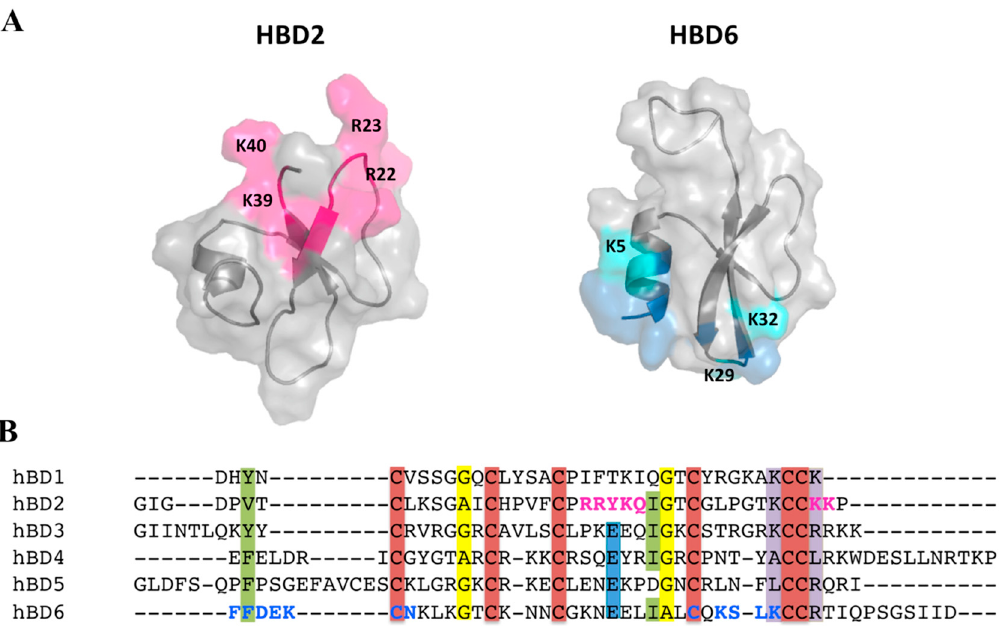
Figure 5. β -Defensin interaction with glycosaminoglycan (GAG), mapped using nuclear magnetic resonance (NMR) chemical shift perturbation (CSP). ( A ) Comparison of the heparin-binding motif mapped on the surfaces of human β -defensin (HBD)2 and HBD6. Residues exhibiting pronounced NMR CSP upon GAG binding are highlighted in magenta for HBD2 [53] and blue for HBD6 [41] on the surface and in the primary sequence. The CSPs for HBD2 were reproduced from [53]. ( B ) Sequence alignments for six HBDs, performed using ClustalW software. Protein names are indicated on the left; amino acids are color-coded based on conservation scores 9, calculated using the ConSurf server. Highly conserved Cys, Gly, Glu, and basic residues are shown in red, yellow, blue, and purple backgrounds, respectively.